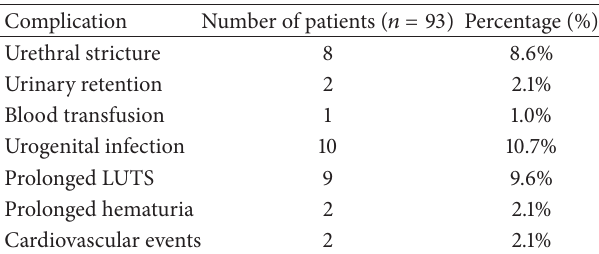
Table 5: Comparison of the surgical outcome, operation time, catheterization time, and hospital stay between the two groups of patients